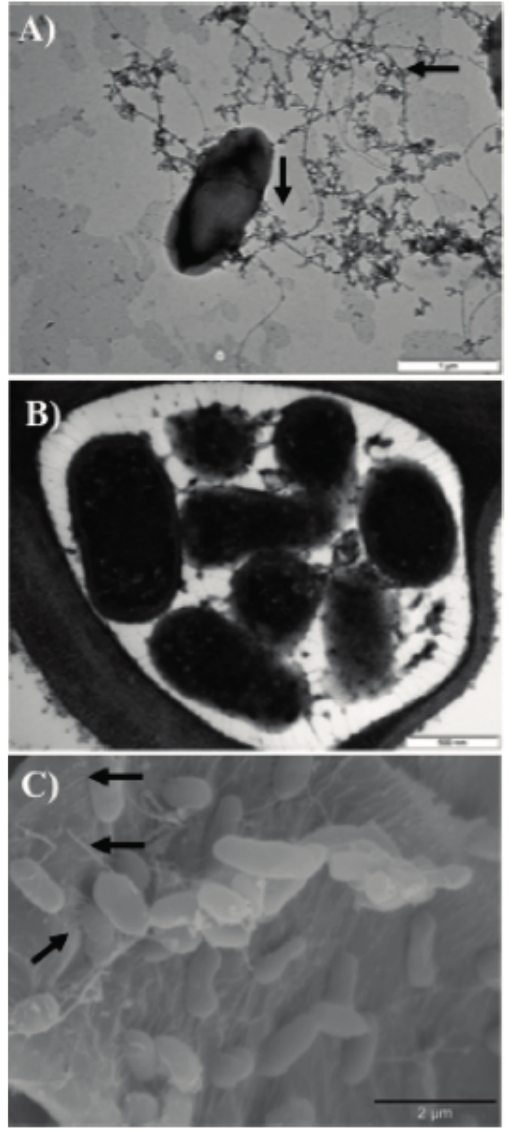
Figure 2. Images of putative attachment structures of E. amylovora [19] (adapted from [19], with permission from American Society for Microbiology). ( A ) TEM imaging of a planktonic E. amylovora cell grown in broth culture and negatively stained. Peritrichous flagella are indicated by arrows (scale: 1 µm); ( B ) TEM image of E. amylovora in planta. Putative attachment structures connect bacterial cells to host cells (scale: 1 µm); ( C ) SEM image of E. amylovora cells found within a biofilm, with multiple appendages that protrude from the bacterial cell and attach to the host surface, as indicated by the arrows (scale: 2